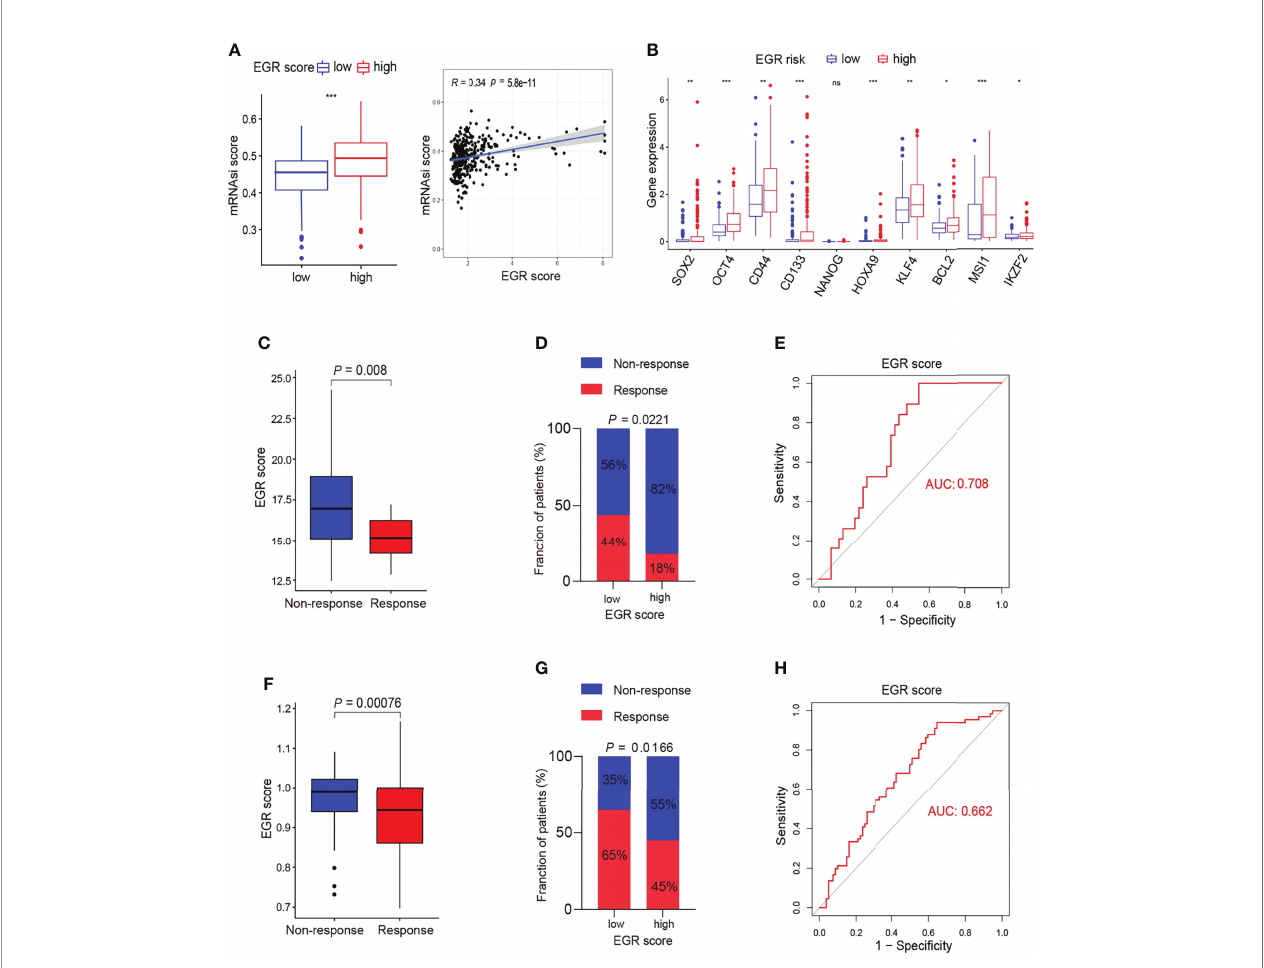
FIGURE 6 | Association of m6Ascore and response to chemotherapy. (A) Boxplot of stemness score between EGRscore-low and EGRscore-high HCC patients. (B) Boxplot of genes associated with stemness between EGRscore-low and EGRscore-high HCC patients. (C) Boxplot of response of chemotherapy between EGRscore-low and EGRscore-high HCC patients. (D) Proportion of EGRscore-high and EGRscore-low group in patients that harbored a response or not in the GSE109211 cohort. (E) ROC curves based on EGRscore in the GSE109211 cohort. (F) Boxplot of response of TACE between EGRscore-low and EGRscore-high HCC patients. (G) Proportion of EGRscore-high and EGRscore-low group in patients that harbored a response or not in the GSE104580 cohort. (H) ROC curves based on EGRscore in the GSE104580 cohort. Statistical signi fi cance was denoted with *(p < 0.05), **(p < 0.01), and ***(p <